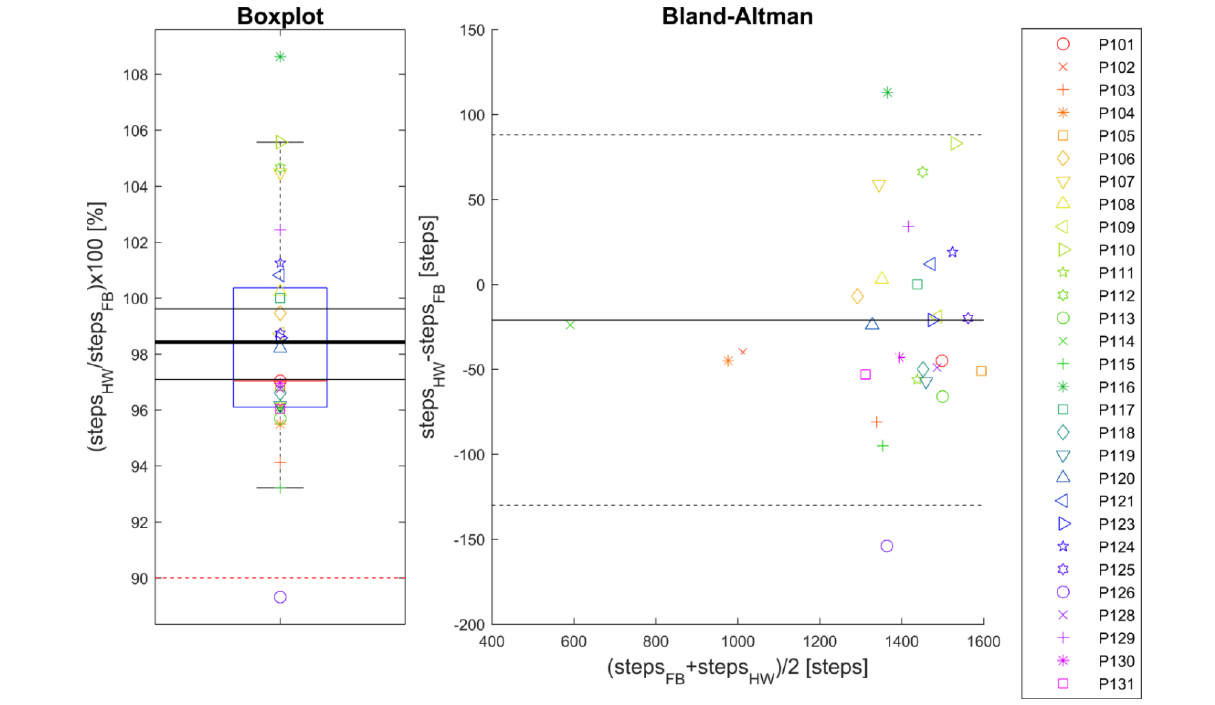
Figure 5. Boxplot (left-hand panel) of estimated step count as ratio between the health watch (HW) and the waist-worn reference (Fitbit One, FB), for all walk activities combined. The thick black line indicates the mean of the data, the red dashed lines the predefined equivalence interval, and the other black lines the calculated 95% CI of equivalence. Right-hand panel: Bland-Altman plot of the estimated step count of the HW and the reference measurement. The solid black line indicates the average bias and the dashed black lines represent the 95% limits of agreement. Symbols represent participants as indicated in the legend, and the legend is the same for both